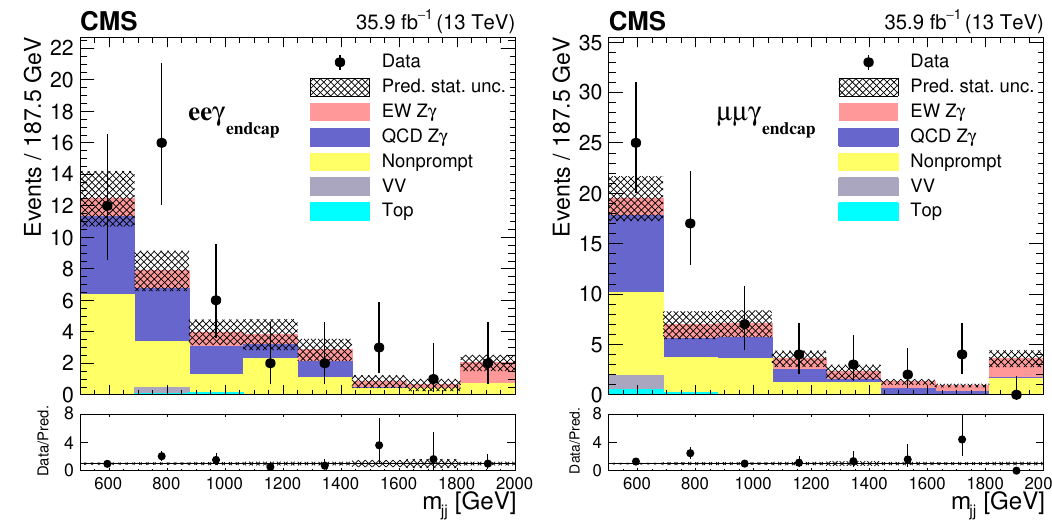
Figure 3 . The pre-(cid:12)t m distributions for the dilepton + (cid:13) events are shown on the left for jj endcap the dielectron and on the right for the dimuon categories. The data are compared to the sum of the signal and the background contribution. The black points with error bars represent the data and their uncertainties, while the hatched bands represent the statistical uncertainty on the combined signal and background expectations. The last bin includes over(cid:13)ow events. The bottom plots show the ratio of the data to the expectation.